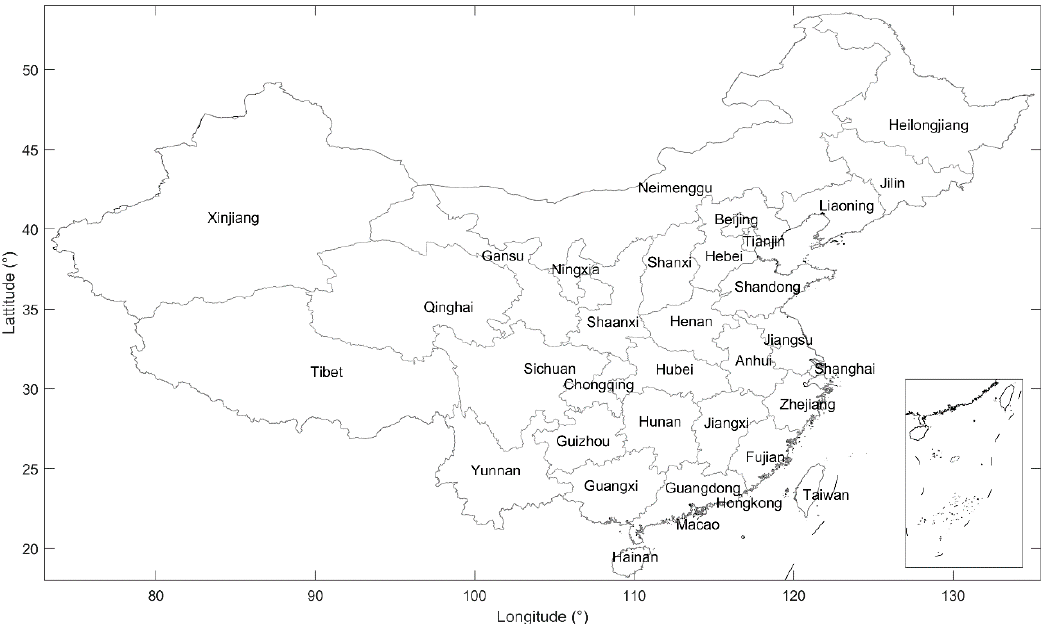
ff erent provinces in